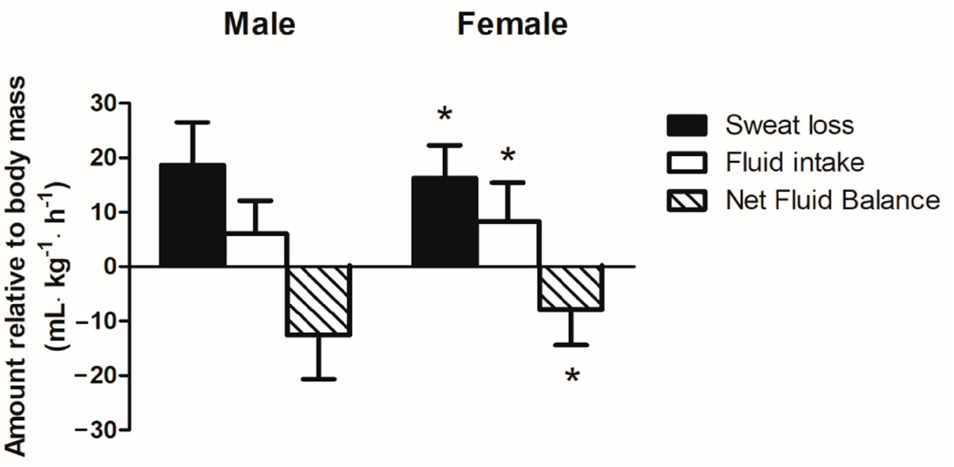
Figure 1. Relative sweat loss, fluid intake, and net fluid balance (mL · kg − 1 · h − 1 ) between sexes. Data are presented as mean ± SD. * p < 0.05, compared to male